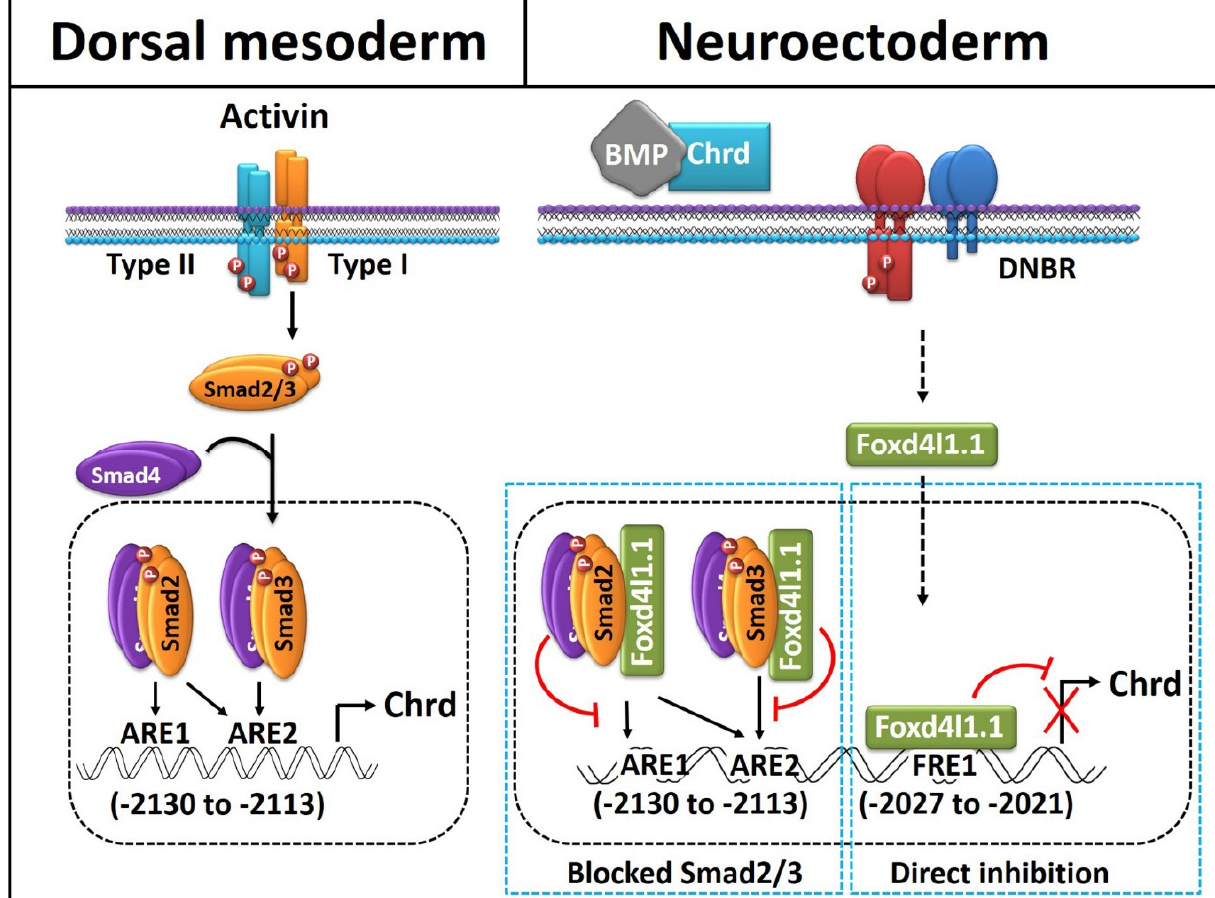
Figure 6. Proposed model of Foxd4l1.1 mediated inhibition of chrd transcription. In dorsal mesoderm for the organizer, activin signaling activates chrd transcription mediated by Smad2 and Smad3. Each Smad interacts with ARE1 and ARE2 within the chrd promoter ( − 2130 to − 2113 bps). The neuroectoderm-specific transcription factor Foxd4l1.1 is directly bound to the FRE1 region of the chrd promoter to inhibit chrd transcription ( − 2027 to − 2021 bps). Foxd4l1.1 physically interacts with Smad2 and Smad3 and blocks binding to the AREs .